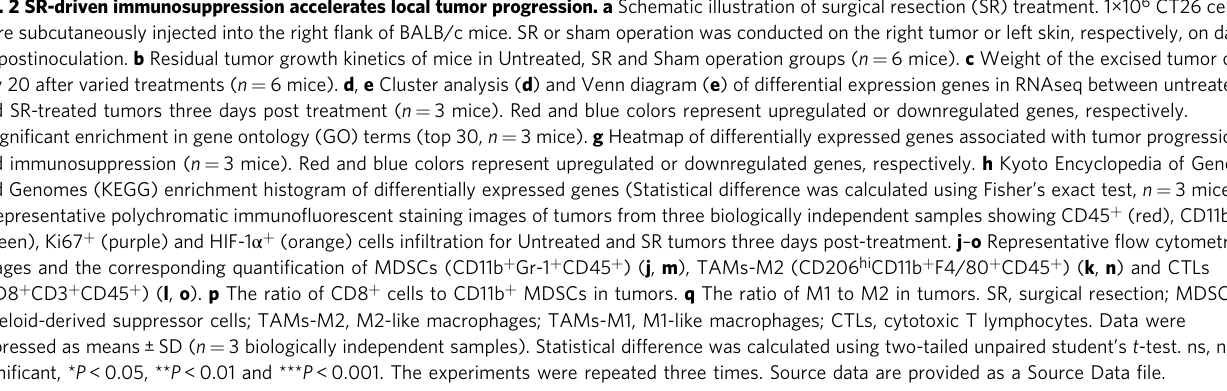
Fig. 3a. Brie fl y, monodisperse solid silica spheres (sSiO 2 ) were fi rstly fabricated by a classical stöber method 24 . After reacting with potassium permanganate (KMnO 4 ) solution, the surface of sSiO 2 was coated with uniform MnO 2 layer. Then, the obtained sSiO 2 @MnO 2 was etched with Na 2 CO 3 solution to obtain HMnO 2 . After that, the obtained HMnO 2 nanoparticles were sequentially modi fi ed and drug loaded to yield the fi nal